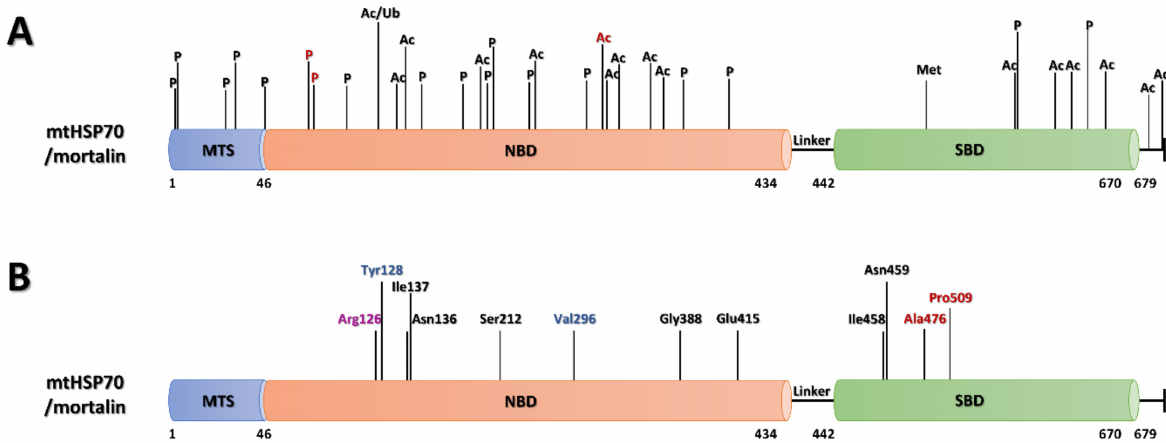
Figure 3. The structural domains of human mortalin highlighting currently known post-translational modifications ( A ) and modified amino-acid residues identified in human diseases ( B ). ( A ) The residue (acetylated Lys288) most frequently identified in MS searches for post-translational modifications [220], and Thr62 and Ser65 phosphorylated by a known protein kinase, MPS1 [222], are colored red. Only modifications identified by at least five separate proteomic studies are shown [220]. ( B ) Those amino acids whose mutations are involved in Parkinson’s disease [158,225], are shown in red; those residues whose modification is associated with EVEN-PLUS syndrome [226], are shown in blue. Arg126 (purple) was found to be modified in both, PD and EVEN-PLUS. The black amino acids were found to be modified in sideroblastic anemia, SIDBA4 [227]. The numbers below each diagram mark the beginning and end of the major divisions of the protein and help to indicate the position of a given amino acid in the protein